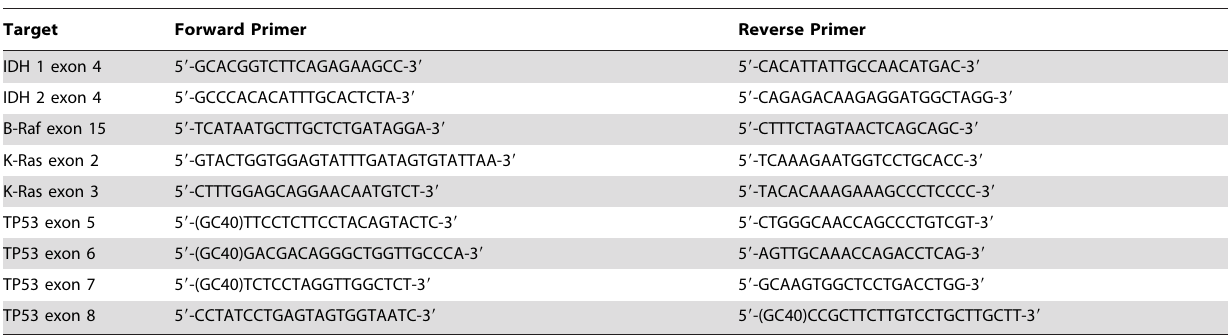
Table 2. Primers used for mutation analyses.